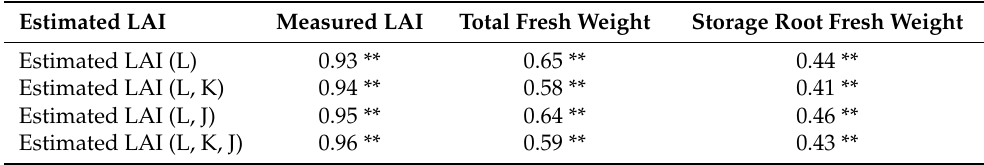
Table 4. Correlation coefficient ( r ) between estimated leaf area index (LAI) (based on a function of the length of the central lobe (L), the product of length and width (K), and the product of length and number of lobes (J) together with the number of leaves) and measured LAI, total fresh weight, and storage root fresh weight. Estimated LAI Measured LAI Total Fresh Weight Storage Root Fresh Weight Estimated LAI (L) 0.93 ** 0.65 ** 0.44 ** Estimated LAI (L, K) 0.94 ** 0.58 ** 0.41 ** Estimated LAI (L, J) 0.95 ** Estimated LAI (L, K,